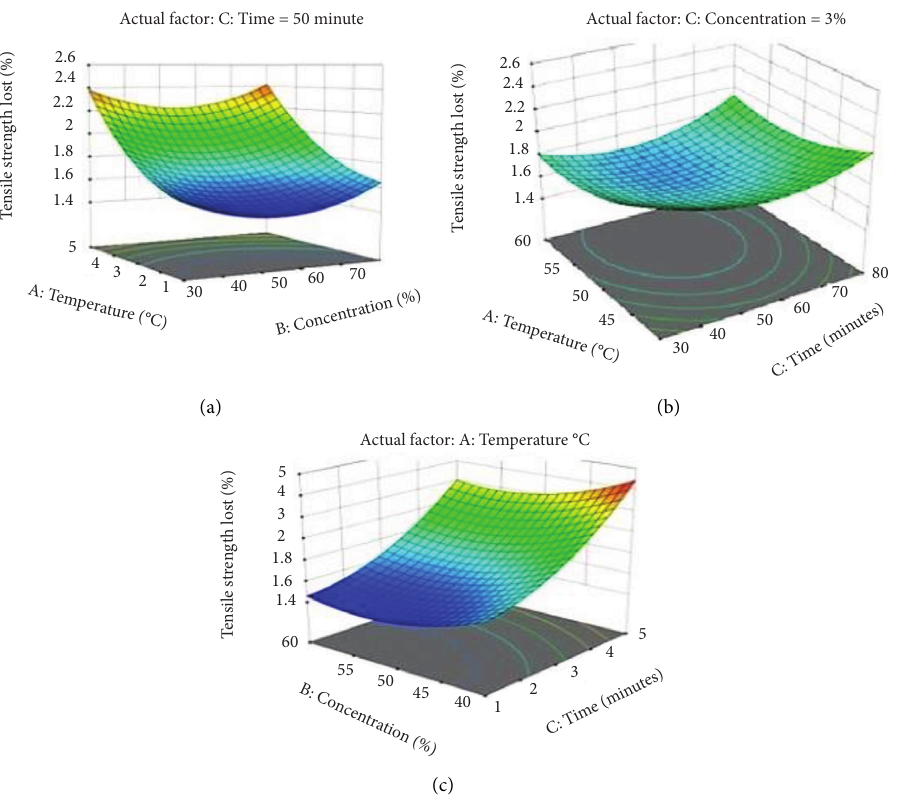
Figure 4: Factor interaction effect, (a) temperature and concentration, (b) temperature and time, and (c) time and concentration on 3D surface graph effect on weight